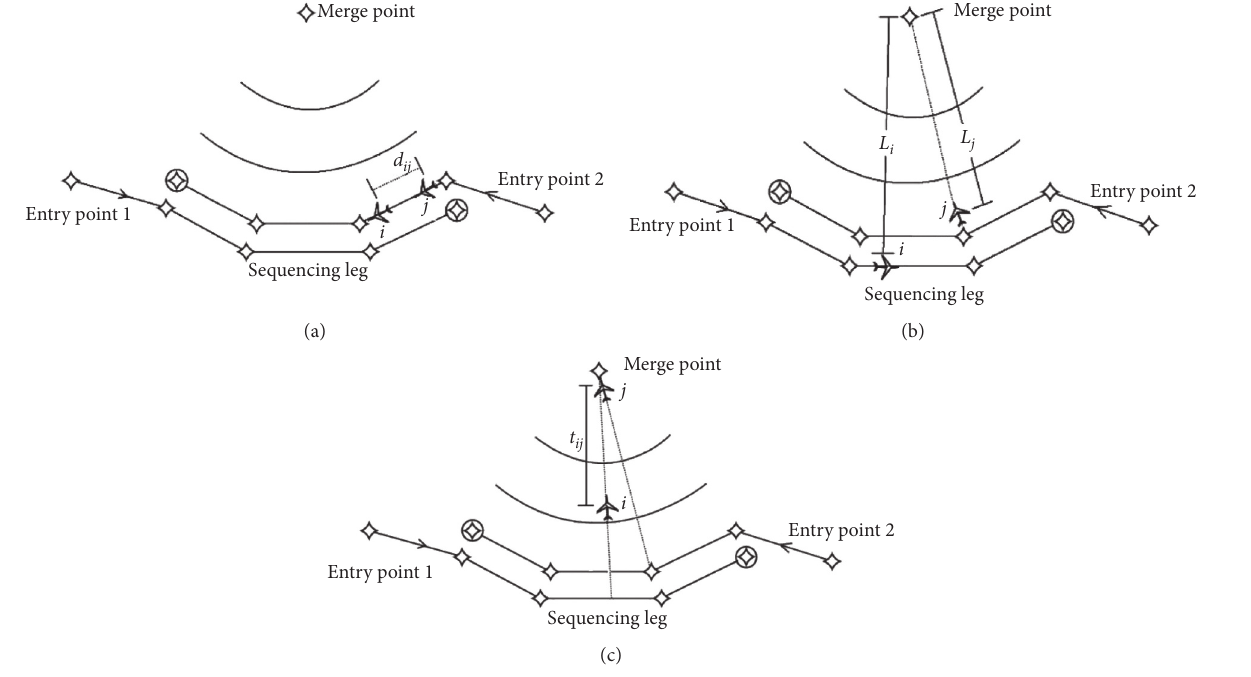
Figure 5: Three situations of conflict detection. (a) Entering. (b) Turning. (c) Merging. Table 1: Aircraft minimum separation.